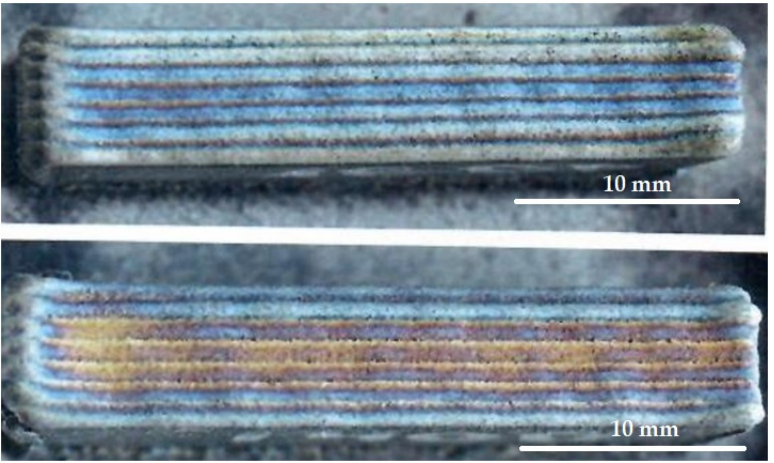
Figure 4. Samples from Ni50Cr33W4.5Mo2.8TiAlNb manufactured by L-DED.